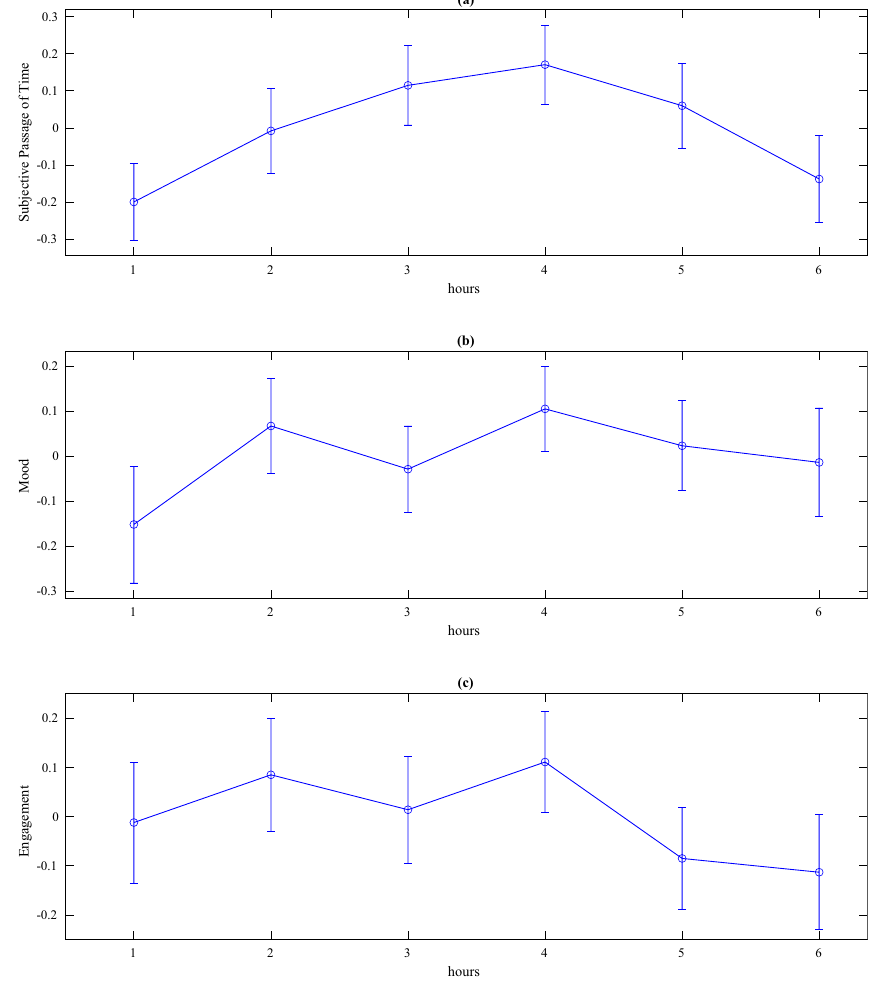
Figure 1. Line plots with error bars for standardised subjective data, ( a ) passage of time judgements ( b ) mood, and ( c ) engagement. Higher scores = time passing quickly ( a ), positive mood ( b ), and very engaged ( c